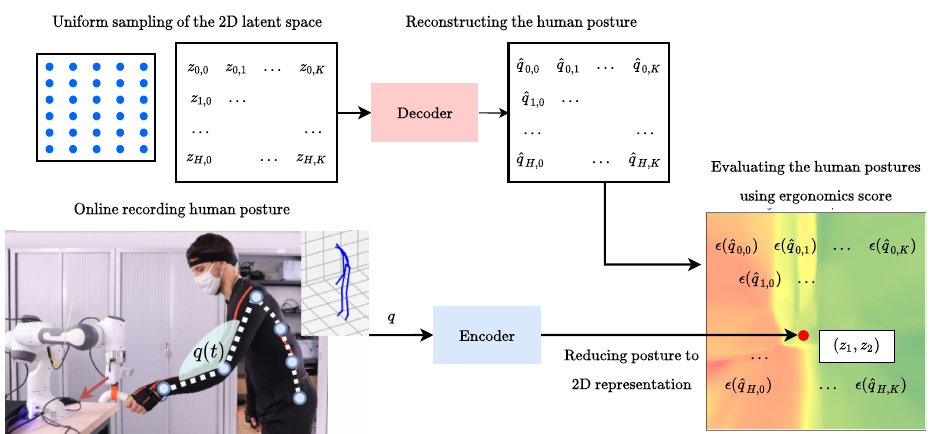
Figure 4. Creation of the LEM: the 2D latent space of the VAE is sampled. The decoder reconstructs sampled latent points. The reconstructed postures are used to compute the ergonomics scores. The ergonomics score is therefore associated with the original 2D points, thus creating a heightmap.